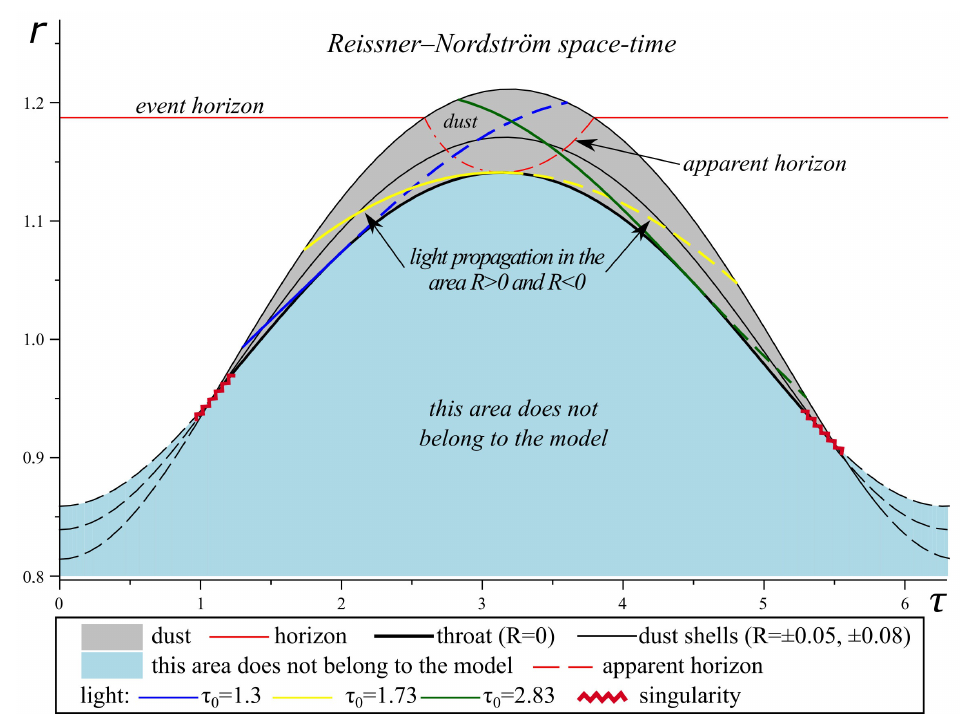
Figure 5. The figure shows the time dependence r ( R , τ ) of dust shells ( R 0 = 0, ± 0.05, ± 0.08, | R | ≤ 0.8) in the case q = 0.99. The curve R = 0 depicts the throat; the curve R = ± 0.08 corresponds to the outer surface. The blue area below the throat does not belong to the model, it does not describe any part of space-time. The dust shells begin and end their motion at singularities, presented by red broken lines. The upper unpainted area depicts the Reissner–Nordström space-time; the red horizontal line corresponds to the horizon; the red dot-dashed and dashed lines in the dust layer depict the apparent horizon, which is also the location of possible turning points for ingoing and outgoing light rays. The green, yellow, and blue curves correspond to propagation of photons, emitted from the shell R = 0.08 at different times τ 0 , in the region R > 0 (solid lines) and R < 0 (dashed lines). Light propagation outside the dust layer is not shown.